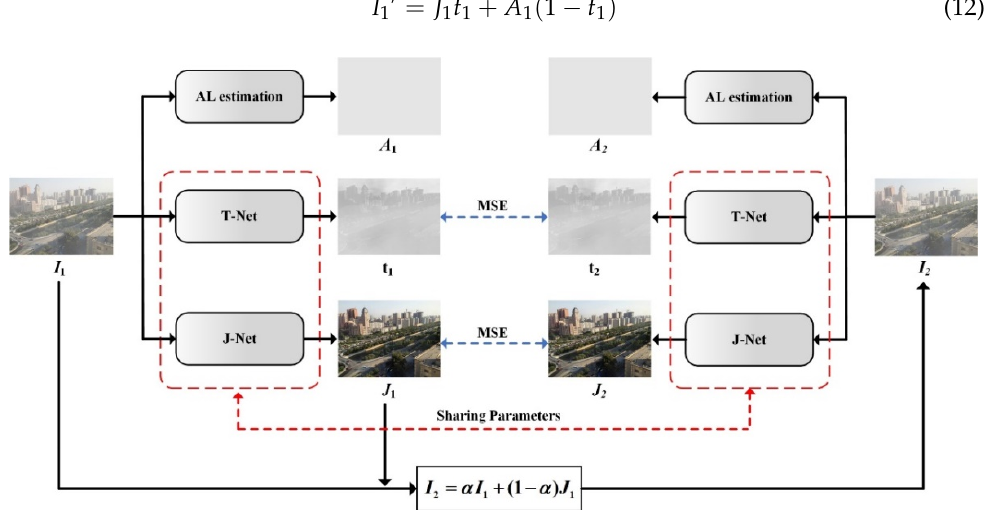
Figure 1. The schematic illustration of the proposed dehazing network. AL estimation is the atmospheric light estimation module. T-Net and J-Net represent two joint subnetworks to estimate the transmission map and haze-free image. I 1 is the hazy input image and I 2 is the re-degraded hazy image by mixing up I 1 and J 1 with a ratio α . MSE denotes minimizing the dissimilarity of two images by minimizing the mean square error. Note that the two T-Nets and J-Nets have sharing parameters marked by the red dotted line.